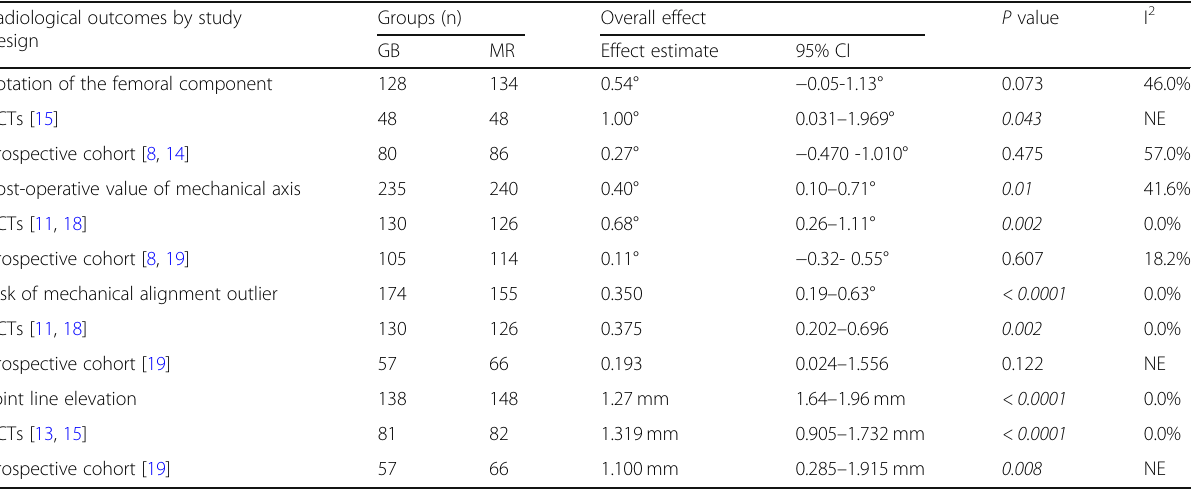
Table 4 Subgroup analysis of radiological outcomes Radiological outcomes by study design